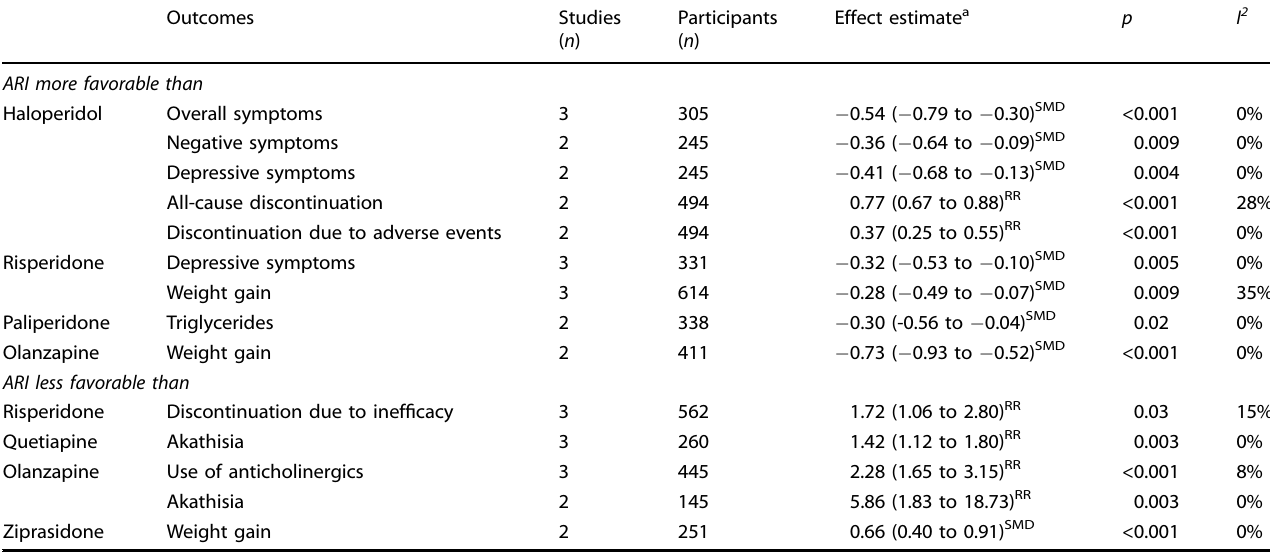
Table 3. Signi fi cant results of comparing aripiprazole with individual D Outcomes Studies